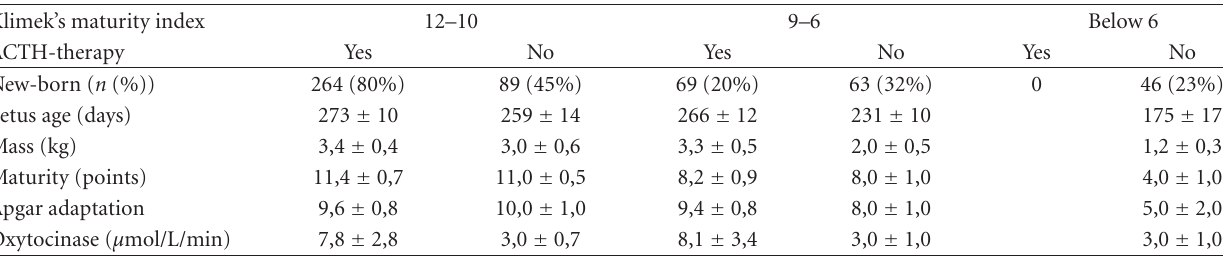
Table 4: Comparison of the state of the newborn according to the reached level of maturity depending on the use of ACTH-depot or tocolysis in the examined